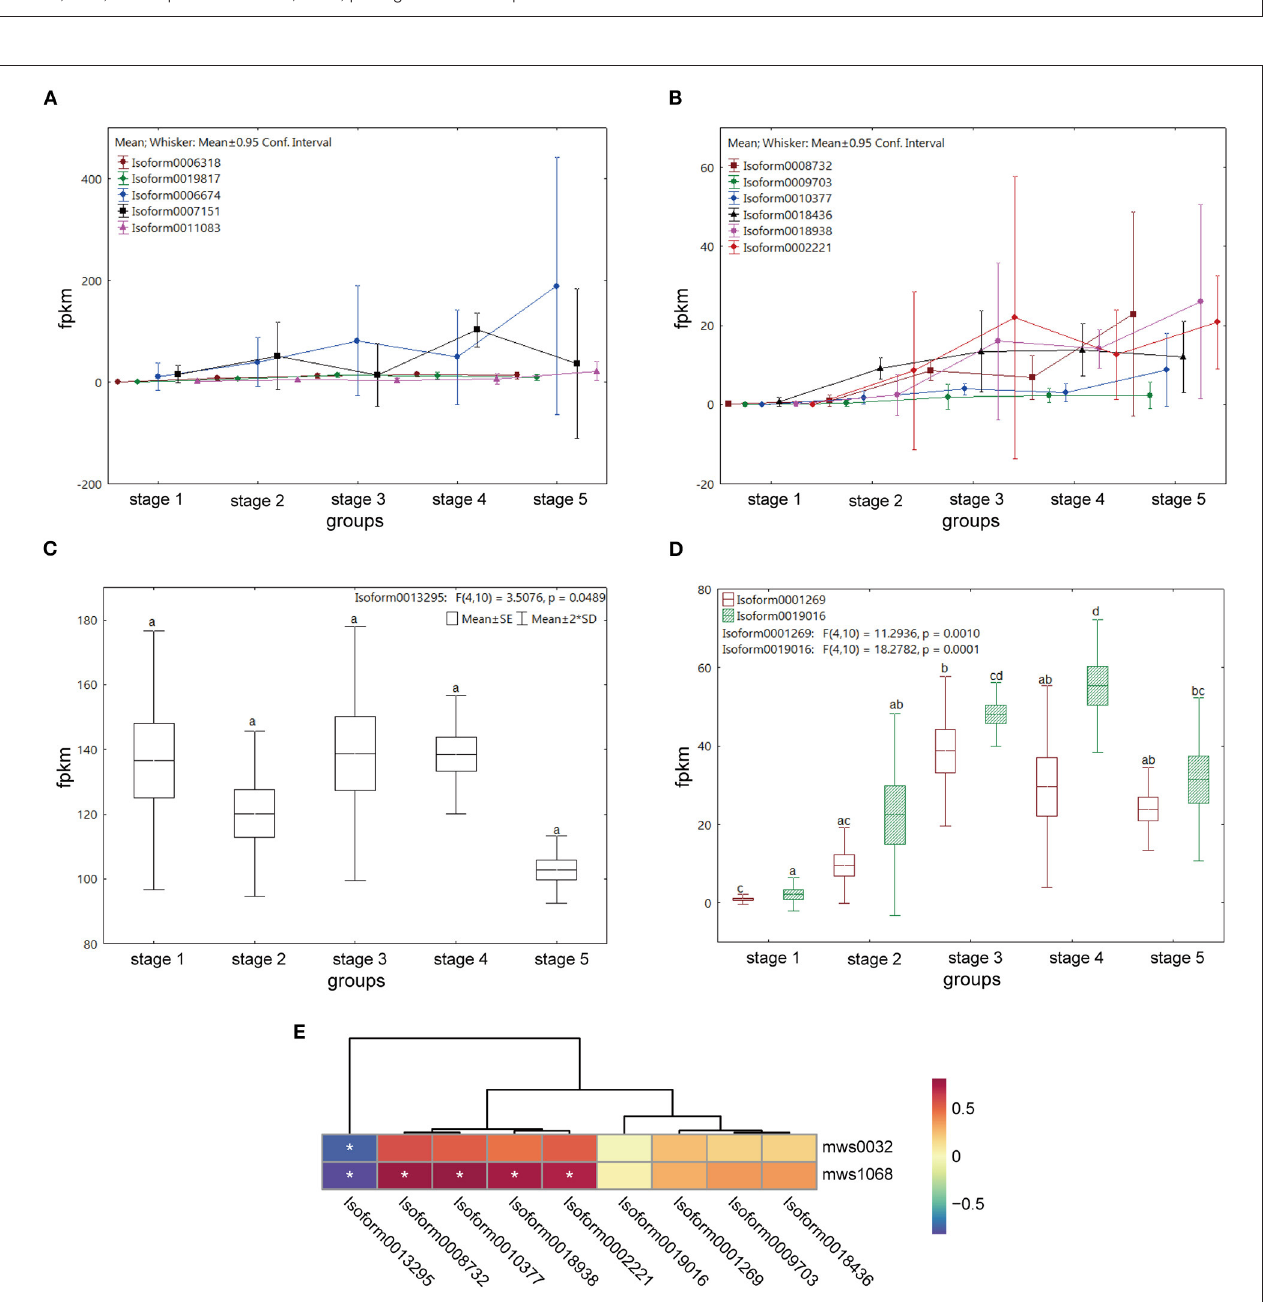
FIGURE 10 | Expression of the genes encoding polar auxin transport carriers at the five stages and its correlation with flavonol contents during stages 4 and 5 in M. pasquieri . (A) Expression of five genes encoding AUX. (B) Expression of six genes encoding LAX. (C) Expression of the gene encoding PIN4. (D) Expression of two genes encoding ABCB1. AUX/LAX, Auxin1/Like-AUX1; PIN4, pin-formed protein4; ABCB1, ATP-binding cassette subfamily B1. (E) Heatmap of correlation between genes encoding polar auxin transport carriers and flavonol contents during stages 4 and 5. In the color bar, red represents a positive correlation, and blue represents a negative correlation. * p <